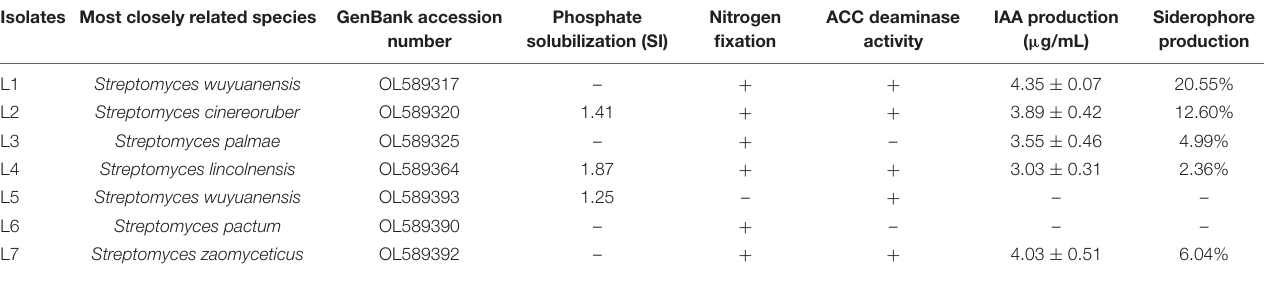
TABLE 1 | Plant-promoting potentials of seven Streptomyces isolates. Isolates Most closely related species GenBank accession